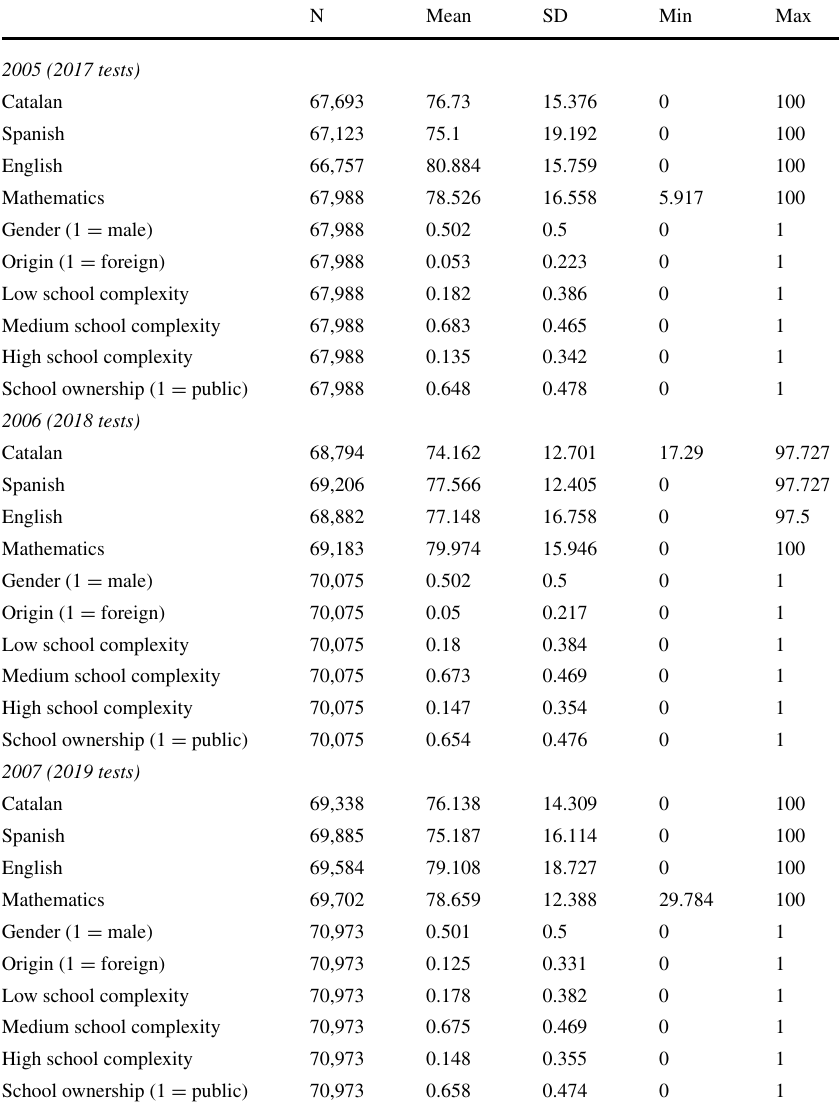
Table 1 Descriptive statistics by student year of